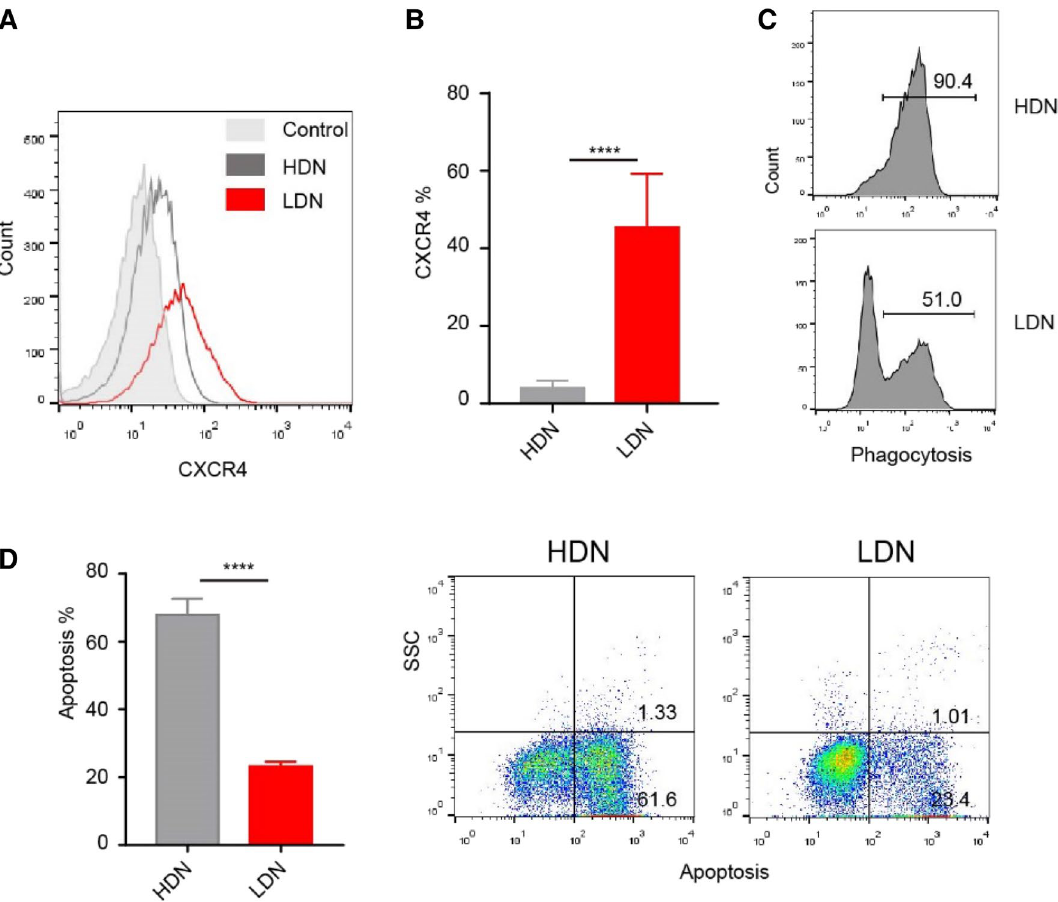
Figure 4. Changes in phagocytosis, apoptosis and surface molecular marker of LDNs in sepsis. ( A , B ) Expression of CXCR4 on HDNs and LDNs. ( C ) The phagocytosis of HDNs and LDNs analyzed using flow cytometry. ( D ) Apoptosis of HDNs and LDNs analyzed using flow